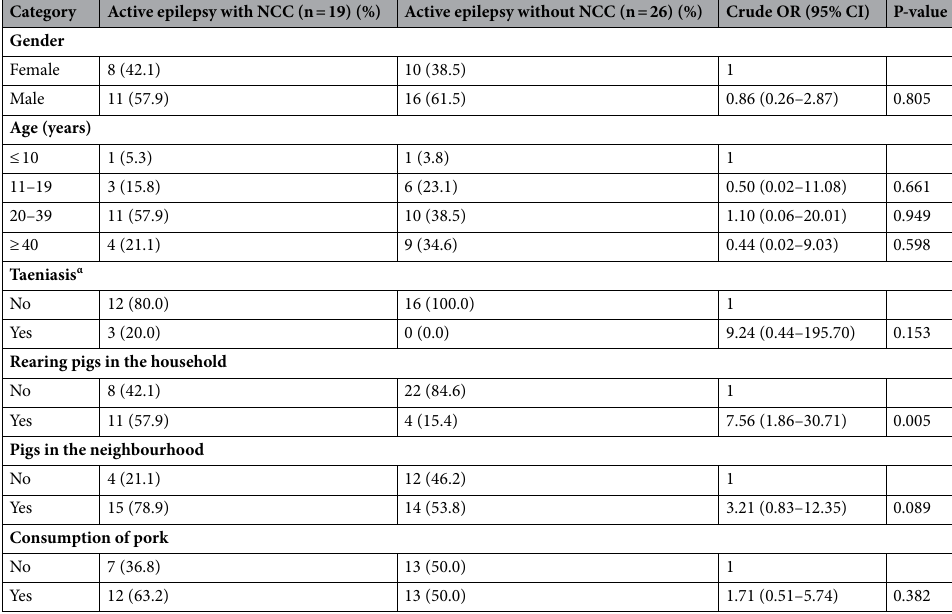
Table 4. Univariate analysis showing the association of selected factors and risk of active epilepsy with neurocysticercosis vs active epilepsy without neurocysticercosis. Odds ratio (OR), 95% confidence interval (CI) and P- value were derived using univariate logistic regression analysis. α Data missing in some cases which were excluded from the